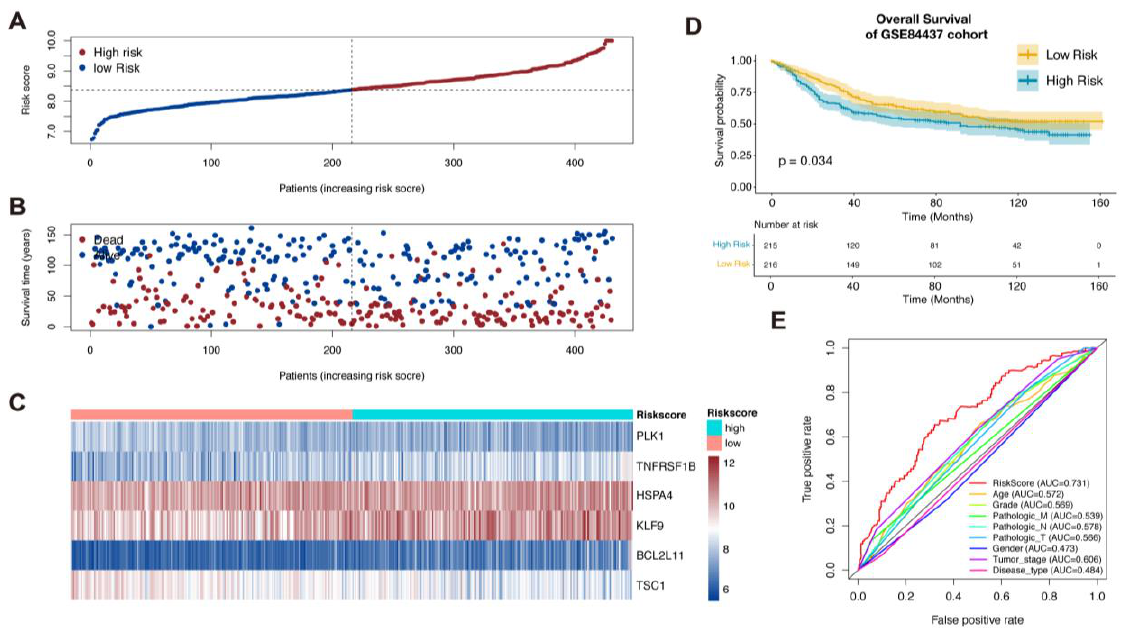
Figure 2. Validation of the necroptosis-related prognostic signature in GSE84437 and establishment of nomogram. ( A – C ) Patients in GSE84437 were sorted by risk score according to the necroptosis-related prognostic signature. ( D ) Kaplan–Meier survival analysis of GSE84437 patients to validate the necroptosis-related prognostic signature. ( E ) Comparison ROC analysis between necroptosis-related prognostic signature and the clinical factors.